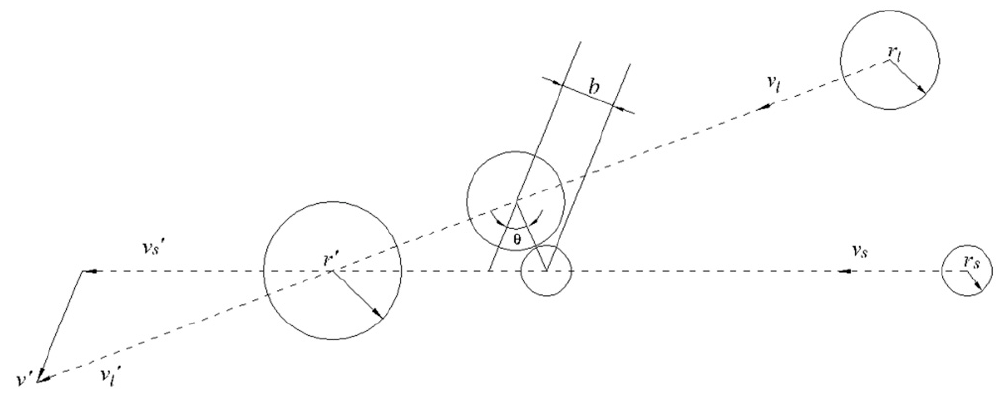
Figure 4. Schematic diagram of the coalescence process.